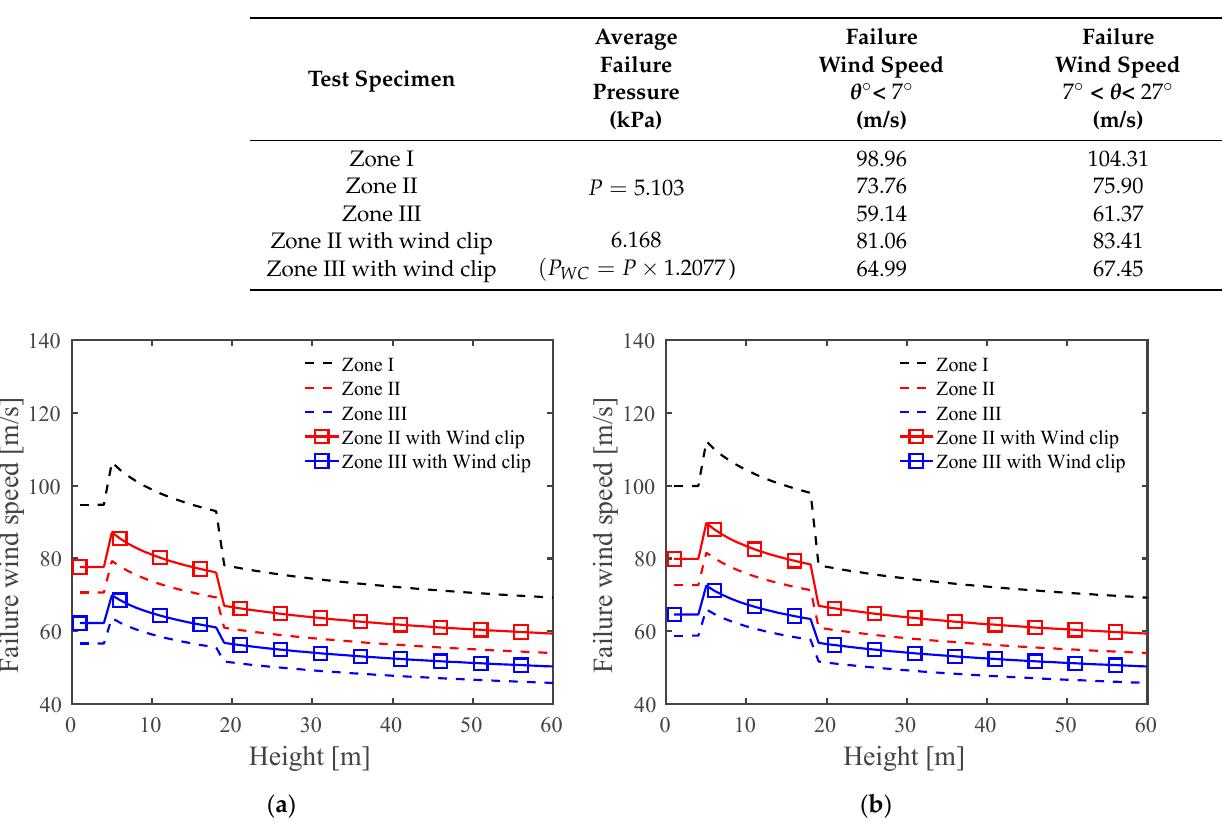
Table 5. Failure wind speed with and without wind clips at 10 m building height.